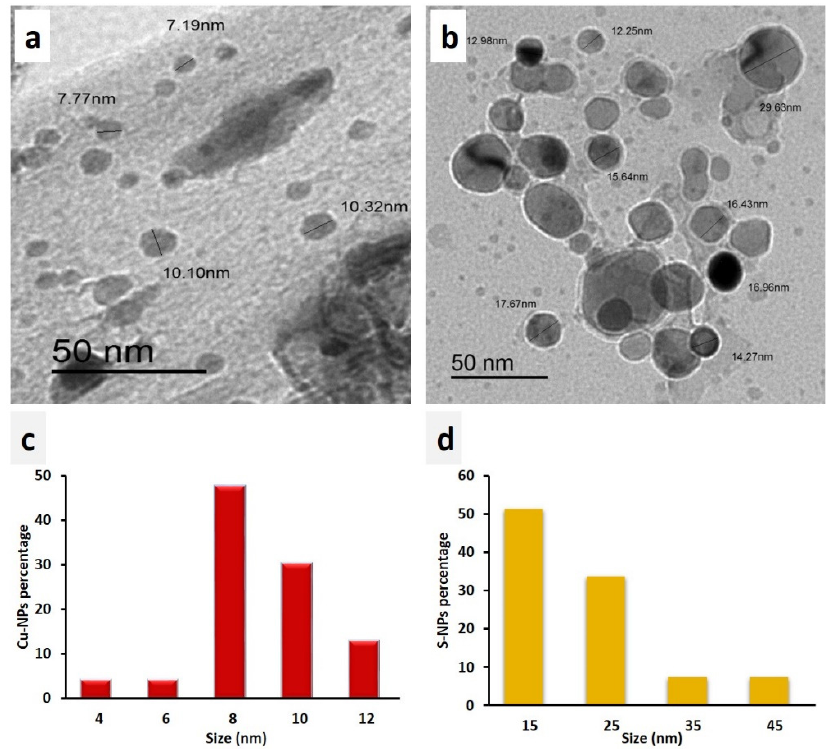
Figure 1. TEM micrographs of ( a ) Cu-NPs, ( b ) S-NPs, ( c ) Cu-NPs histogram, and ( d ) S-NPs histogram.